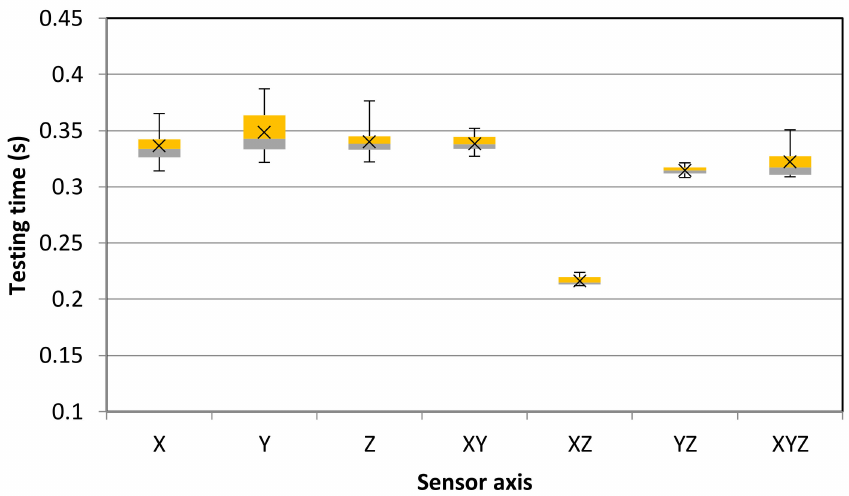
Figure 26. Box plot of ‘testing time’ for all sensor axis of the dynamometer.